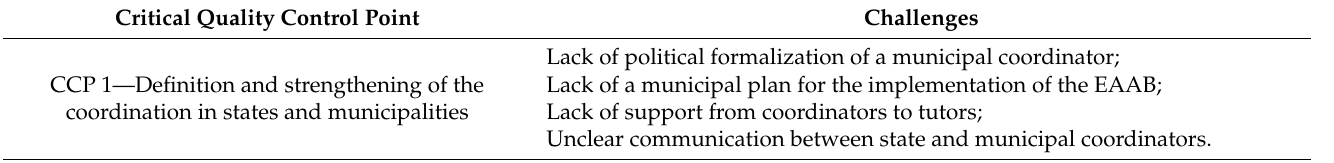
Table 2. Critical Quality Control Points and Assumptions based on the barriers in the implementation of the